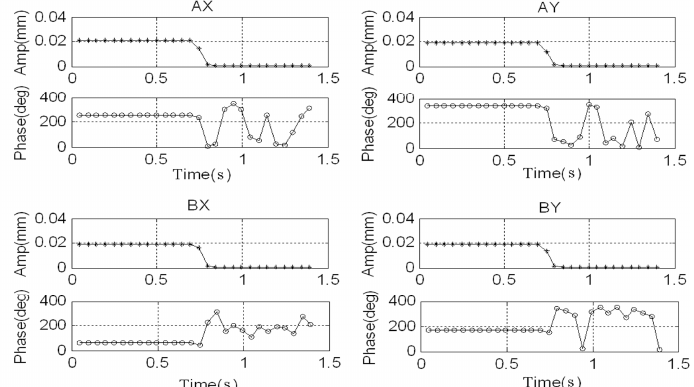
Figure 18. Amplitude and phase of synchronous displacement before and after adding the GPF.